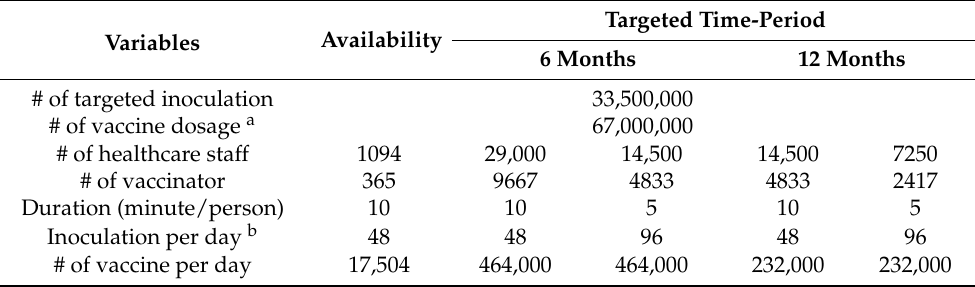
Table 1. Estimation of required numbers of healthcare staff, vaccinators, and vaccine dosages per day for 6- and 12-month